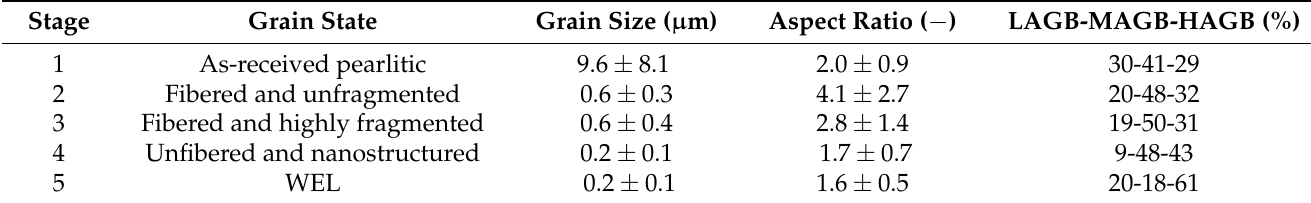
Figure 7. Longitudinal cross section of a rail extracted from region with a high WEL frequency [55]; the microstructural gradient consists of four areas representing the differents evolution stages leading to WEL formation. Stage 2 is the fibrous state of the grains without fragmentation; stage 3 is a state where the grains are still fibrous but fragmented; stage 4 is a state where the grains have no particular orientation and are very fragmented; and stage 5 is the state that appears white in optical microscopy after Nital etching. Table 3. Evolution of indicators and the stages of evolution from the pearlitic state to the final WEL state according to [45].